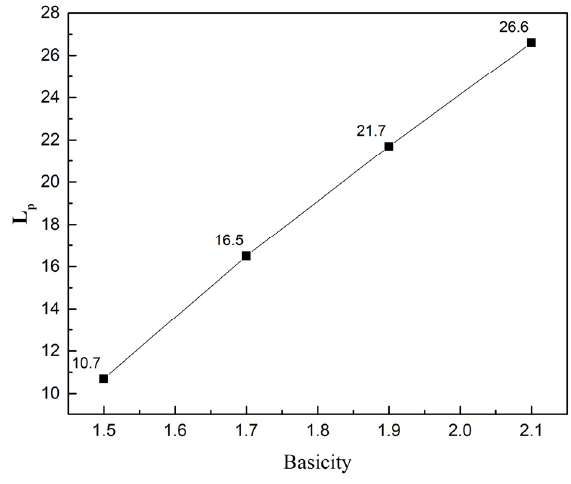
Figure 6. The effect of slag basicity on the L p .